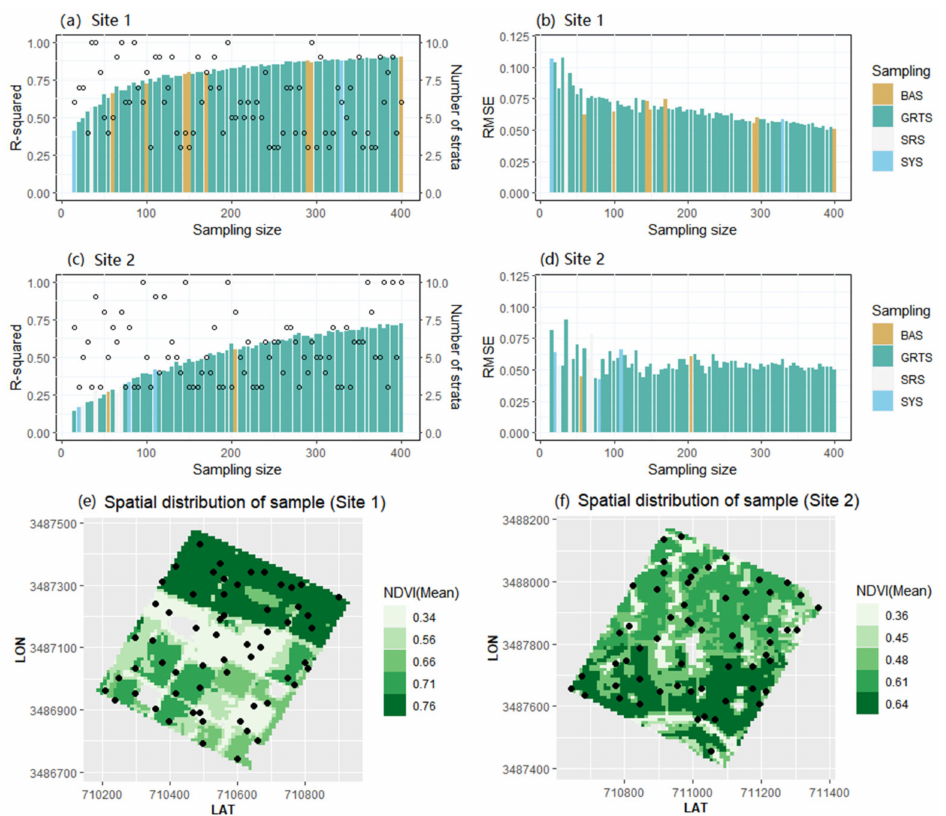
Figure 4. Sampling result based on INTEG-STRAT strategy: ( a – d ) represent R-squared and RMSE for sites 1 and 2 for different sampling size (the black circles represent numbers of strata and the colors of the bar represent sampling method in the optimal combination determined by INTEG-STRAT strategy); ( e , f ) shows the distribution of the sample using INTEG-STRAT strategy when sampling size is 60 (the black points represent the spatial location of sample and color scheme represent the clusters stratified using